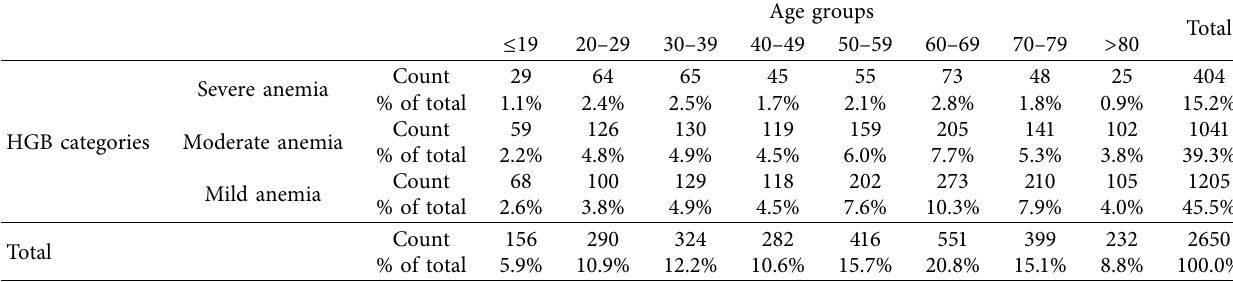
Table 3: Severity of anemia across age groups in males.